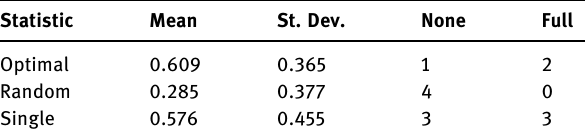
Table 3: Summary statistics of the achieved memory scores for reproducing the plan using a normalized score. The column “ none ” states for each video the number of participants with a 0 score;